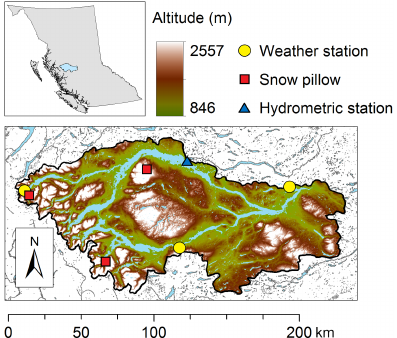
Figure 1. The Nechako watershed and the locations of weather sta- tions, snow pillows and a hydrometric station. All of these contain at least daily weather data. The outlet is considered to be at the spill- way, located at the blue triangle. The intake is located at the Tahtsa Intake weather station (westernmost yellow